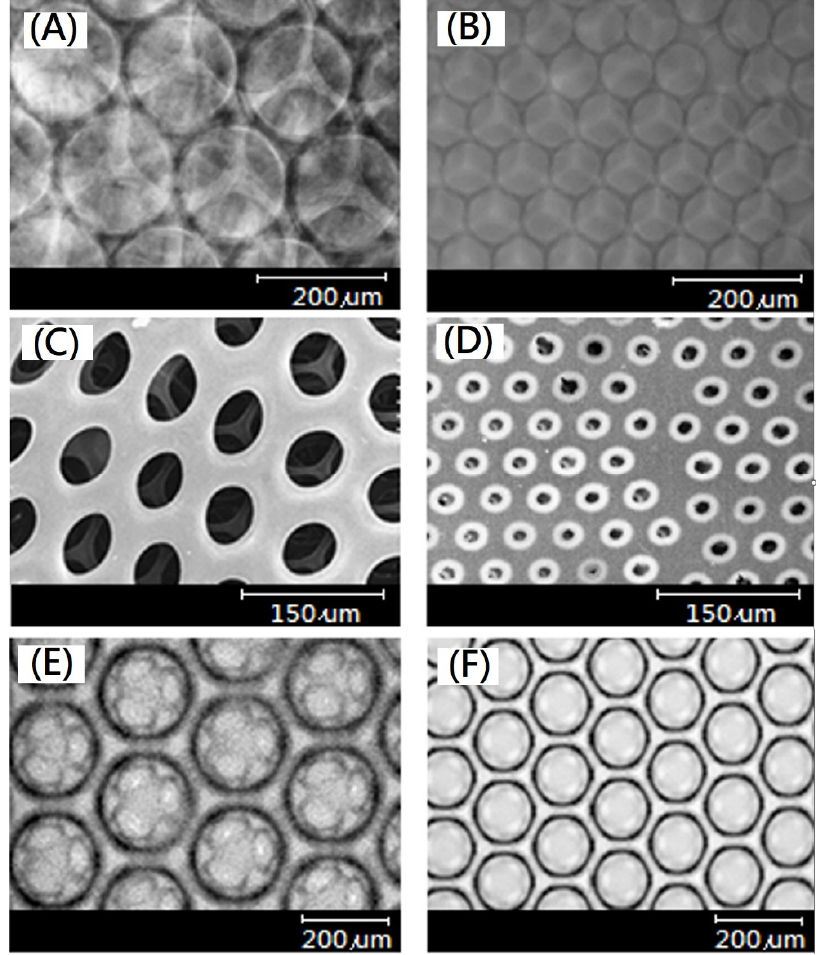
Figure 2. Microscope results of EDC-crosslinked gelatin-based hydrogel scaffolds having ( A ) pores with diameter of 160 μ m and ( B ) pores with diameter of 100 μ m, scanning electron microscope of ( C ) pores with diameter of 160 μ m and ( D ) pores with diameter of 100 μ m, and conjugate focus fluorescence microscopy of ( E ) pores with diameter of 160 μ m and ( F ) pores with diameter of 100 μ m.